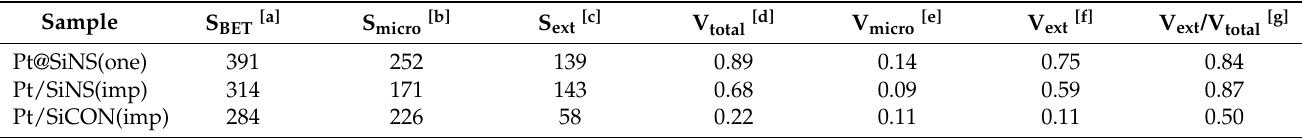
Table 1. Textural properties of the synthesized Pt supported on various silicalite-1 supports prepared by different methods. Sample